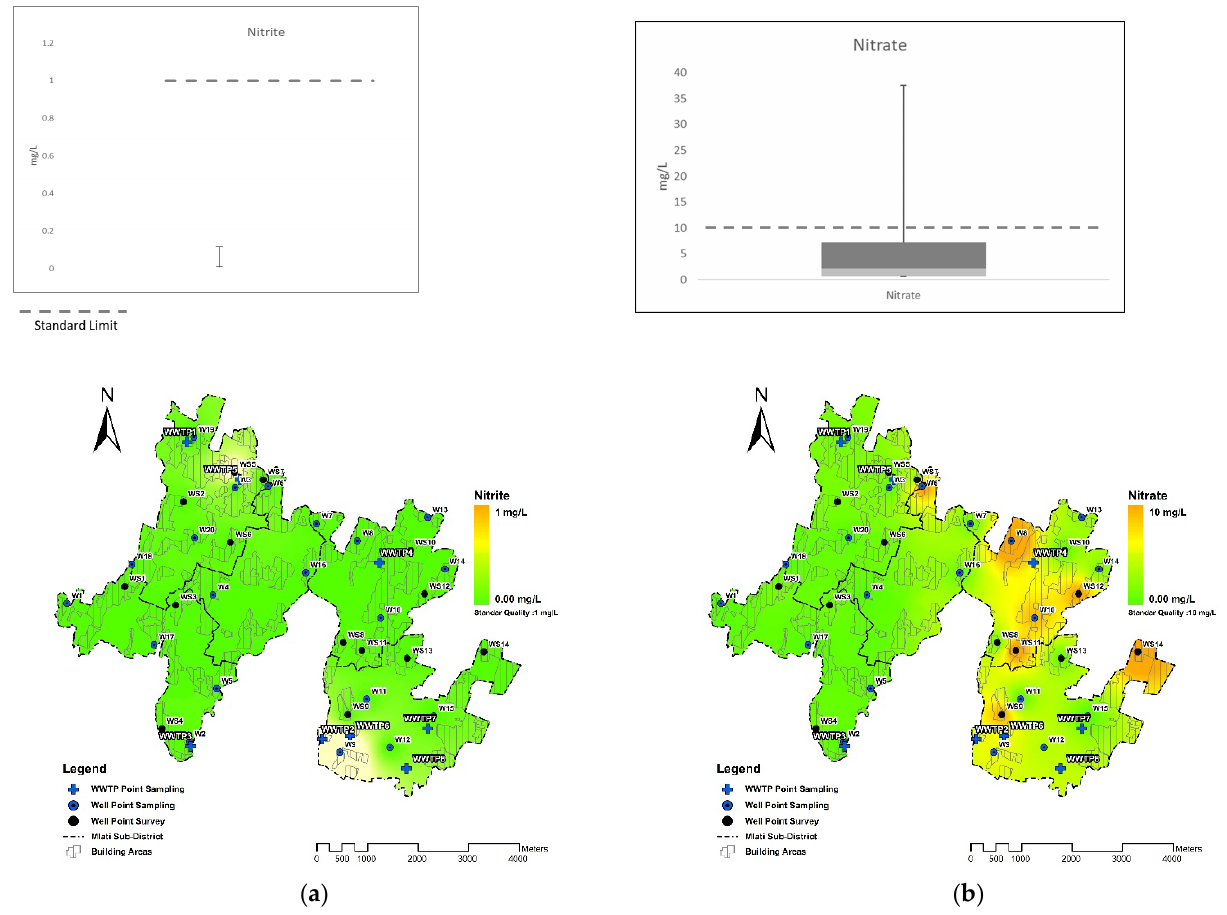
Figure 7. ( a ) Nitrite and ( b ) nitrate concentration and distribution pattern.